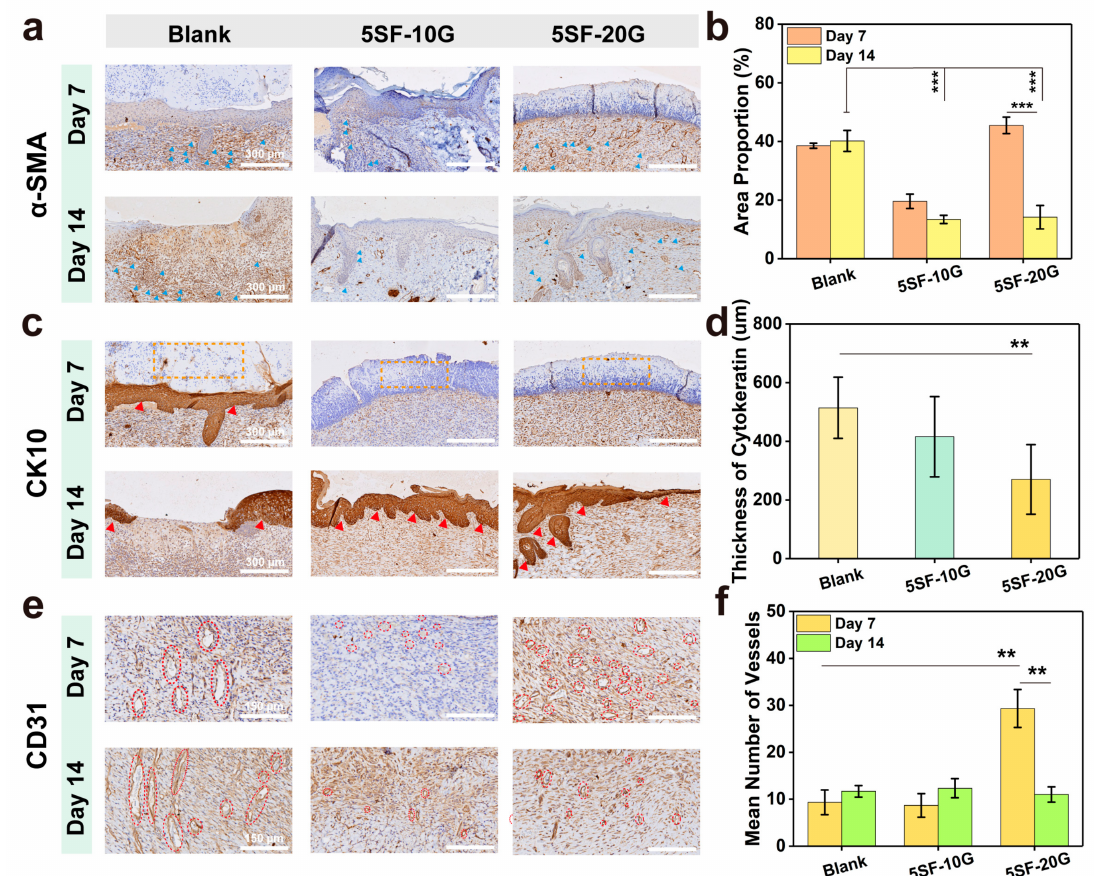
Figure 8. Immunohistochemical staining of wounds treated with hydrogels. ( a ) α -smooth muscle actin ( α -SMA) staining, showing myofibroblasts on days 7 and 14, blue triangles indicated the positive expression of α -SMA, scale bars are 300 µ m. ( b ) CK10 staining, showing keratin in skin on days 7 and 14, orange dotted frames and red triangles indicated the negative and positive expression of keratin, respectively, scale bars are 300 µ m. ( c ) CD31 staining images, representing the extent of vascularisation on days 7 and 14, red dashed circles indicated the vessels, scale bars are 150 µ m. ( d ) The relative density of α -SMA on days 7 and 14. ( e ) The cytokeratin thickness ( µ m) of wounded tissue on day 14. ( f ) Mean number of vessels calculated from CD31 staining. Error bars represent the mean ± s.d.; n = 3, ** p < 0.01, *** p <